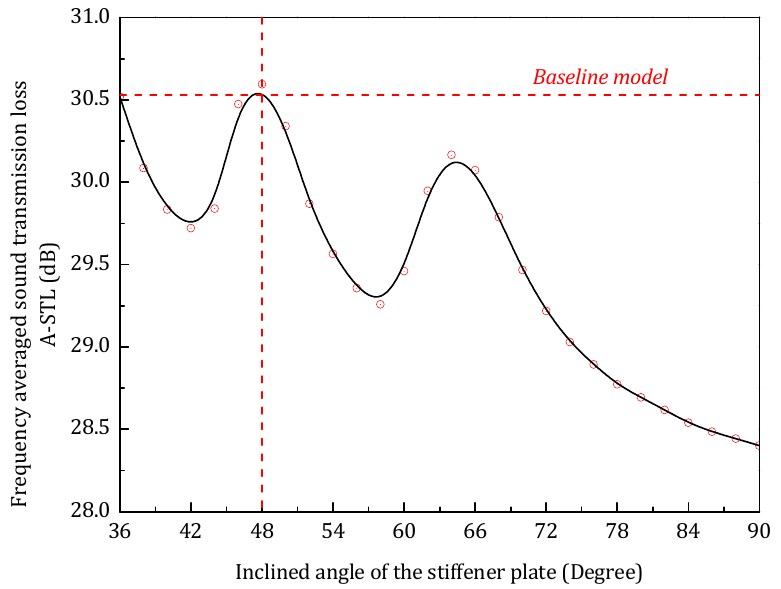
Figure 16. Frequency averaged sound transmission loss with respect to the inclined angle of the stiffener panel.